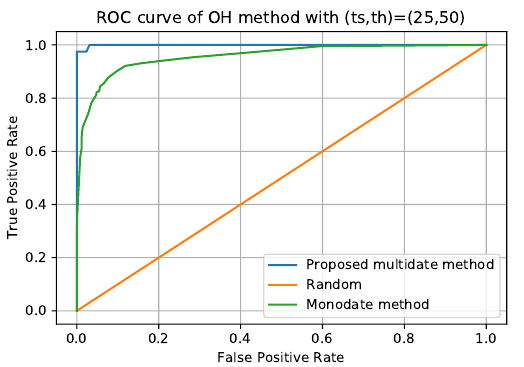
Figure 7. Precision-Recall graph of the multidate method. Each point is obtained by varying ϵ , the NFA